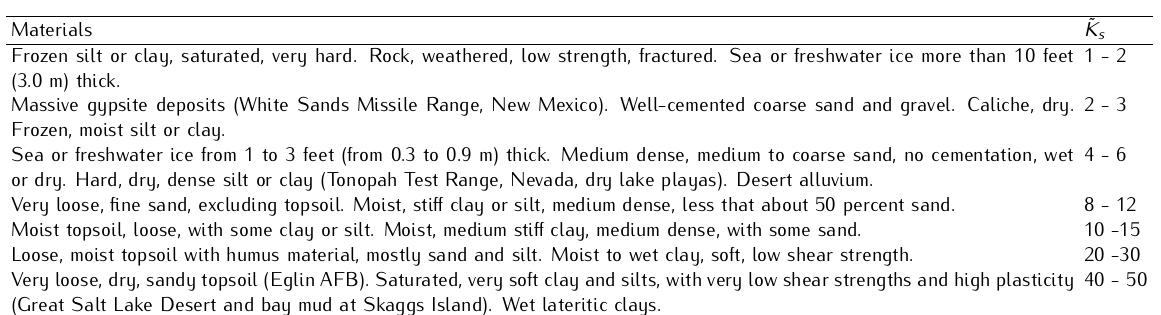
s for typical soils (Young [33]).